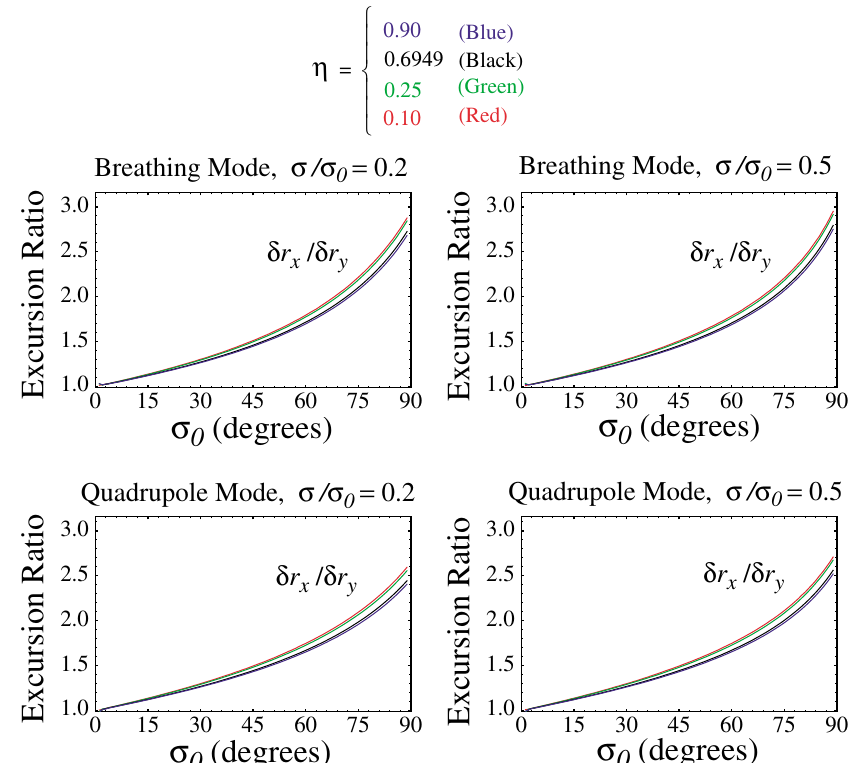
(cid:1) 0 (cid:1) %r 0 and are x y